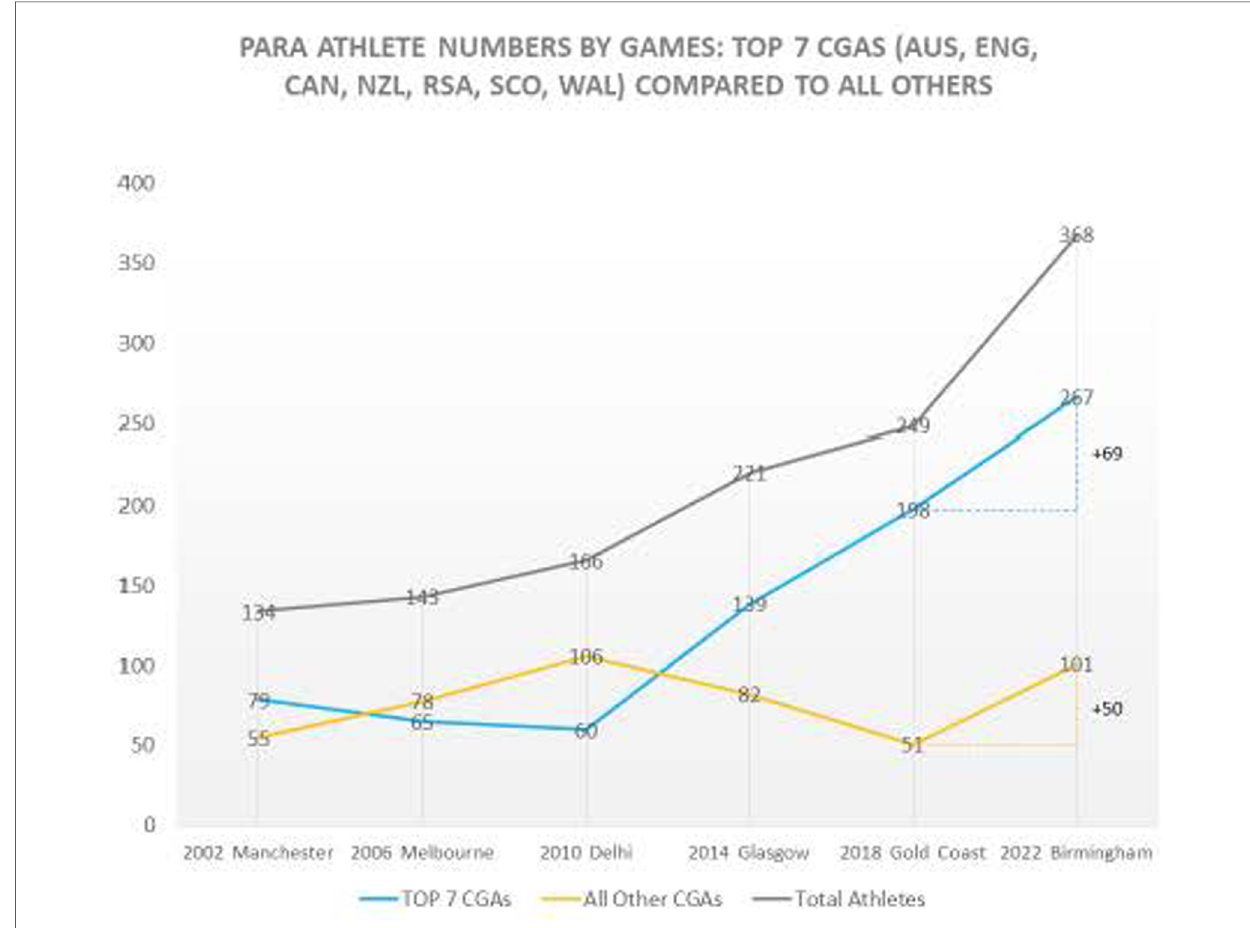
FIGURE 4 Pam sport athletes across CG: the big seven relative to other CGAs. Figure 4 was prepared by CGF post B2022 titled para sport analysis: for the purposes of understanding the impact of GAPS on Birmingham